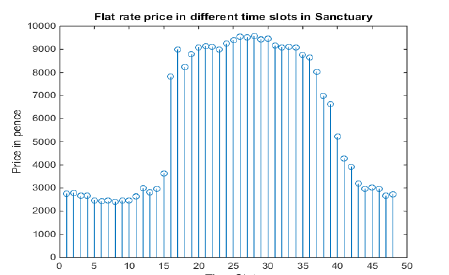
Figure 5. Flat rate pricing in Sanctuary building (sample)